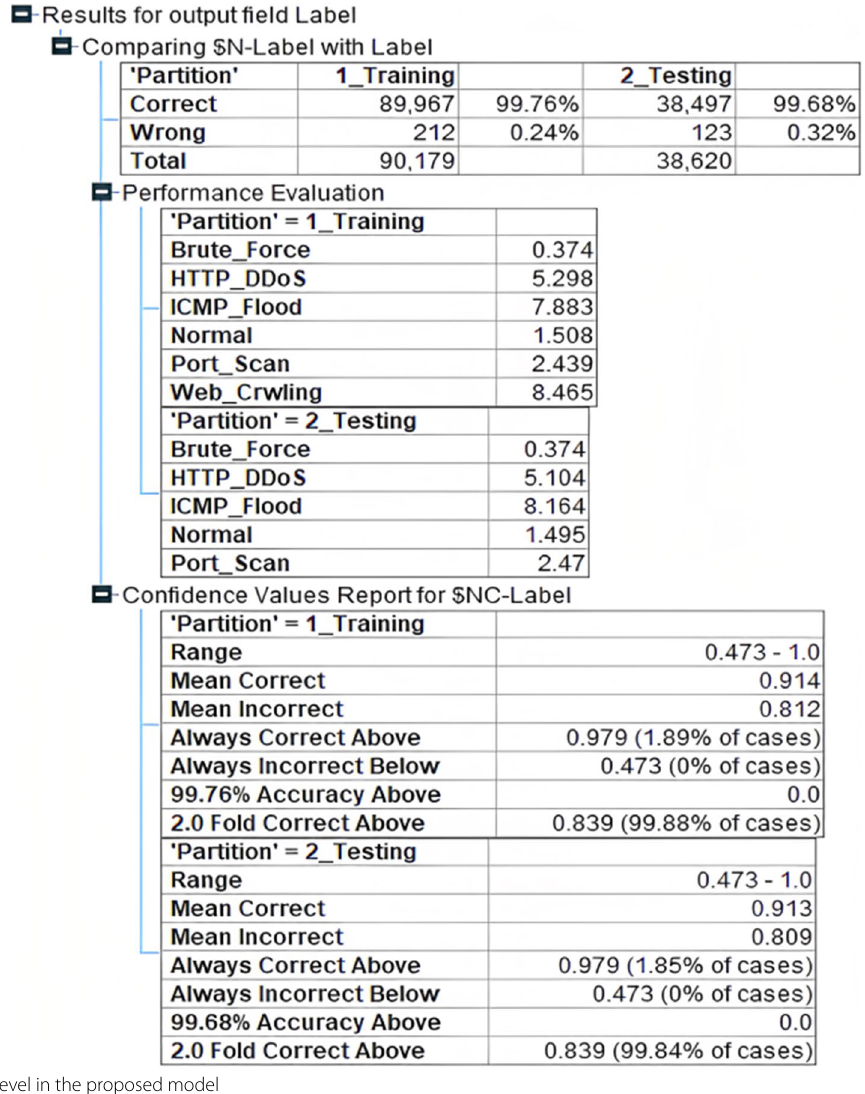
ral Networks in predicting multi-stage cyber-attacks in cloud environments. The confidence Matrix helps to understand the confidence level in the results of various machine learning algorithms [46, 49, 54].